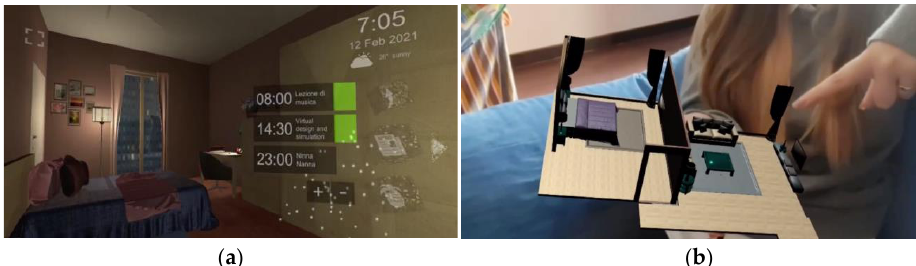
Figure 12. ( a ) Alarm clock GUI; ( b ) vacuum cleaner